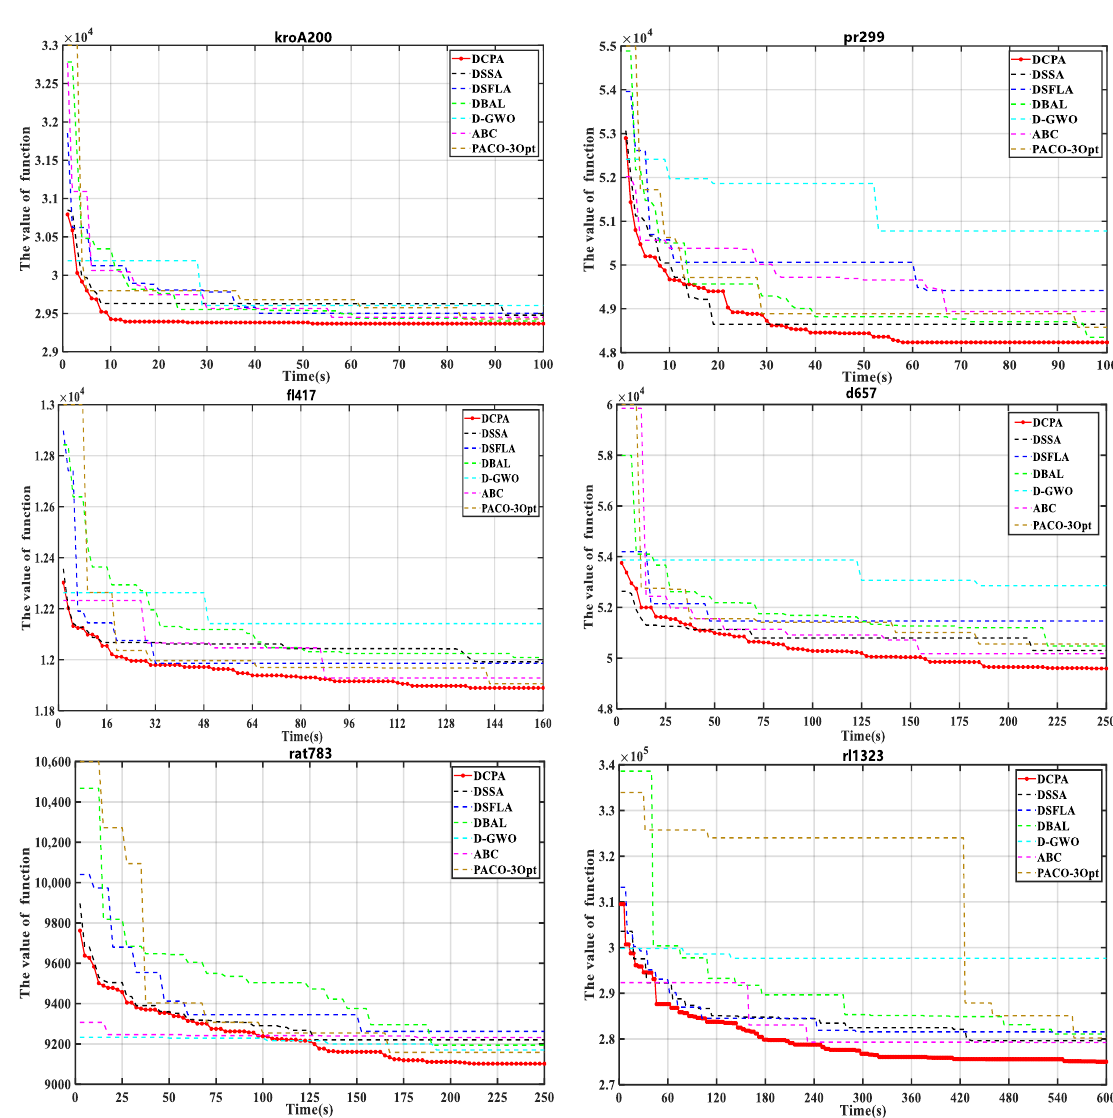
Figure 7. The convergence cure of the participating